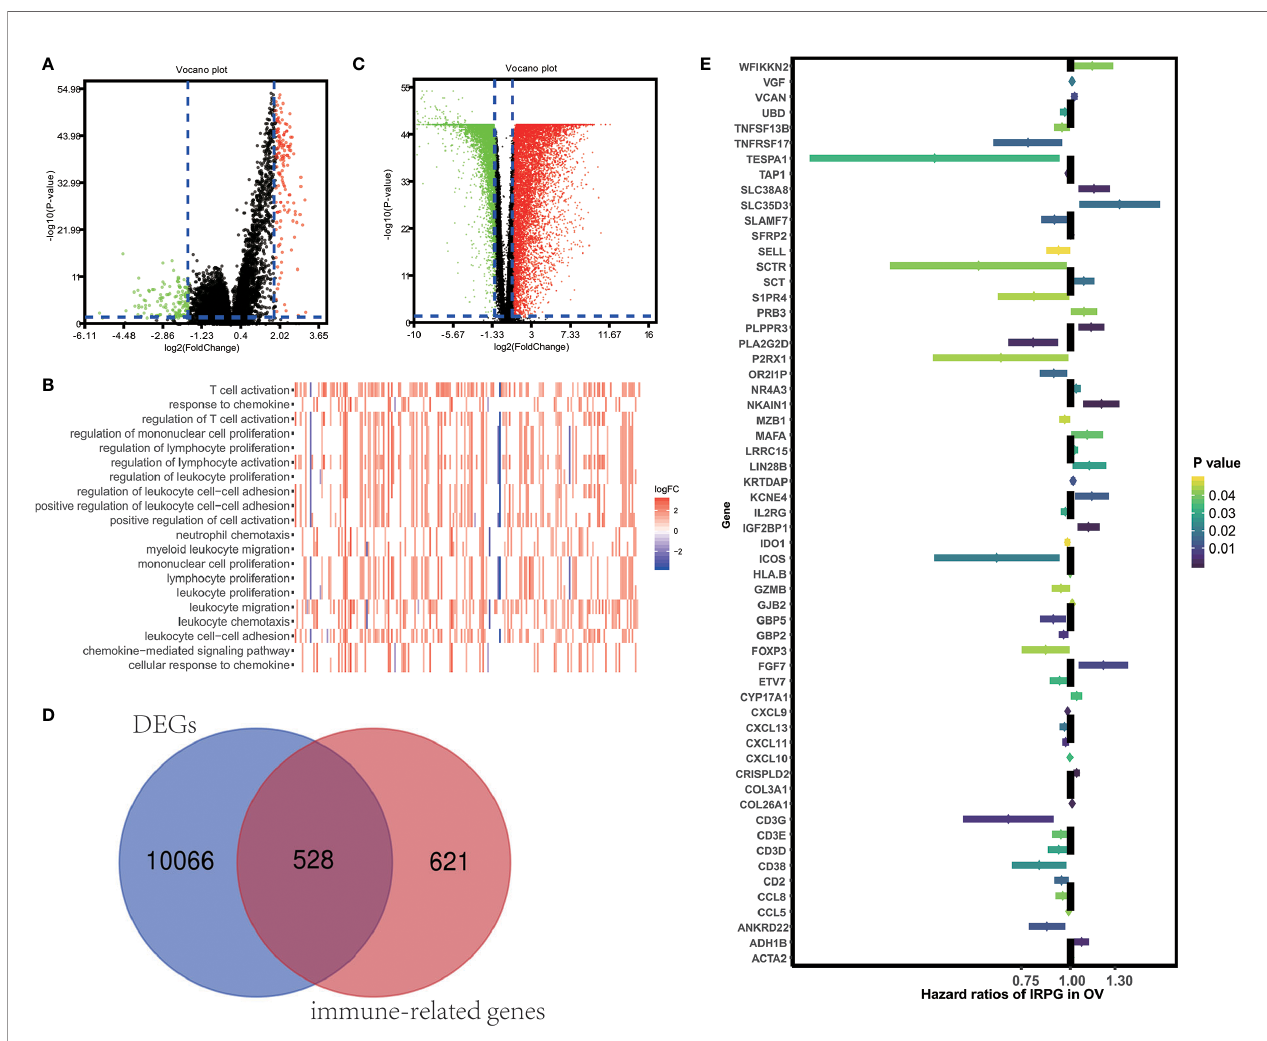
FIGURE 2 | Identi fi cation of immune-related prognostic expressed genes in OV. (A) Genes with differential expression between the low and high immune score groups. (B) Top GO terms which DEGs between high and low immune score groups enriched. (C) Genes with differential expression between tumor and tumor adjacent tissues. (D) Among 10594 up-regulated or down-regulated in tumor tissue, 528 are immune-related genes. (E) The Hazard ratios of identifying immune- related prognostic